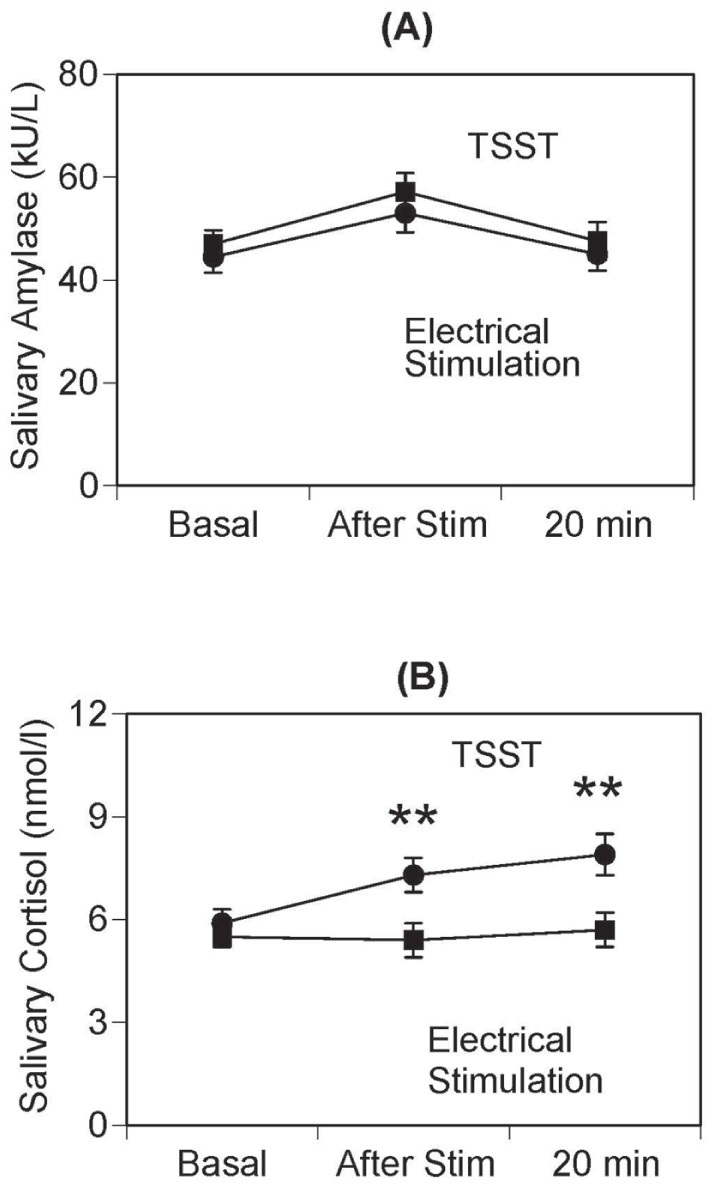
sAA responsiveness between TSST and electrical stimulation.There was no difference in sAA responsiveness between TSST and electrical stimulation challenges (A). In comparison, salivary cortisol responsiveness following TSST exposure was significantly enhanced compared to after electrical stimulation exposure. Values are presented as mean ± standard deviation. ** p<0.01.